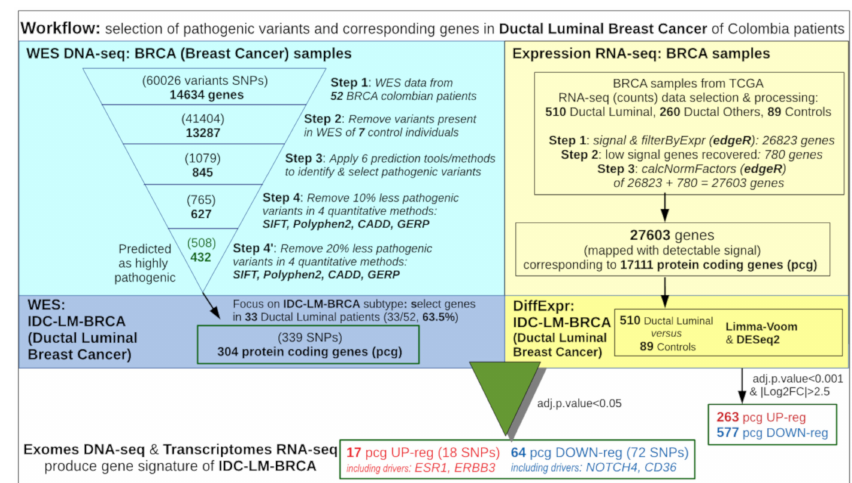
Figure 1. Workflow of the parallel analysis of whole exome sequencing (WES) DNA-seq data and expression RNA-seq data from ductal luminal breast cancer samples, done to select pathogenic variants and corresponding altered genes in a set of Southwest Colombian